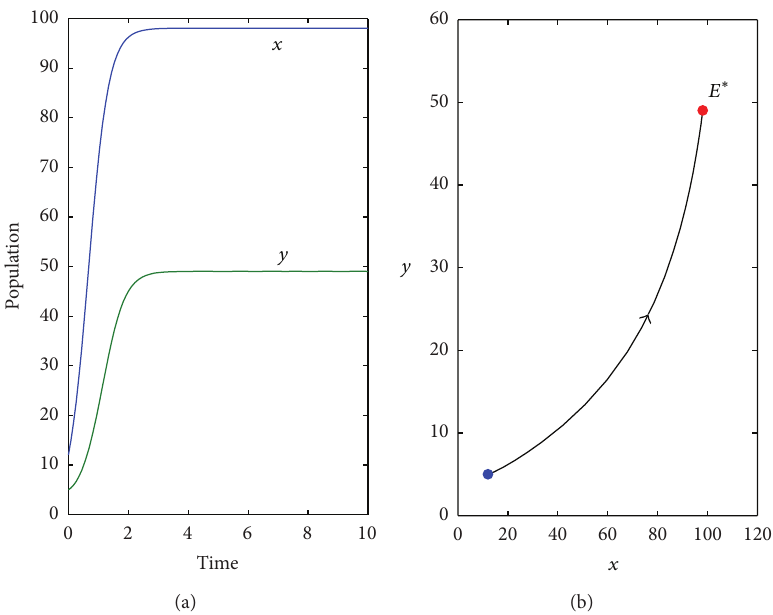
Figure 1: Time series (a) and phase-plane (b) of the system (2). This figure shows that the coexistence equilibrium is asymptotically stable.